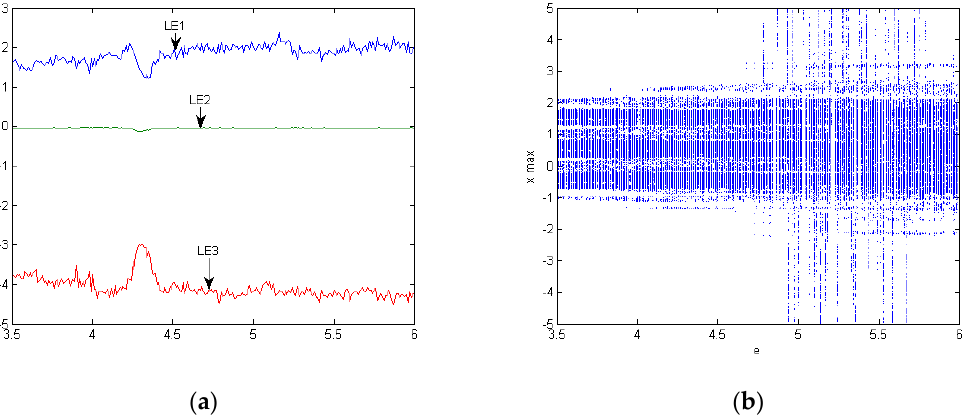
Figure 6. (Color online) Bifurcation diagram and Lyapunov exponents under the conditions of ( ) f 1 ( y ) = f 11 ( y ) , with N 11 = 0, f 2 ( z ) = f 21 ( z ) , with N 21 = 0, f 3 ( x ) with n 1 = 1 and n 2 = 2, a = 1.8, b = 15, c = 6.4, d = 4, and ( x 0 , y 0 , z 0 ) = ( 0.1,0,0 ) : ( a ) Lyapunov exponents and ( b ) bifurcation